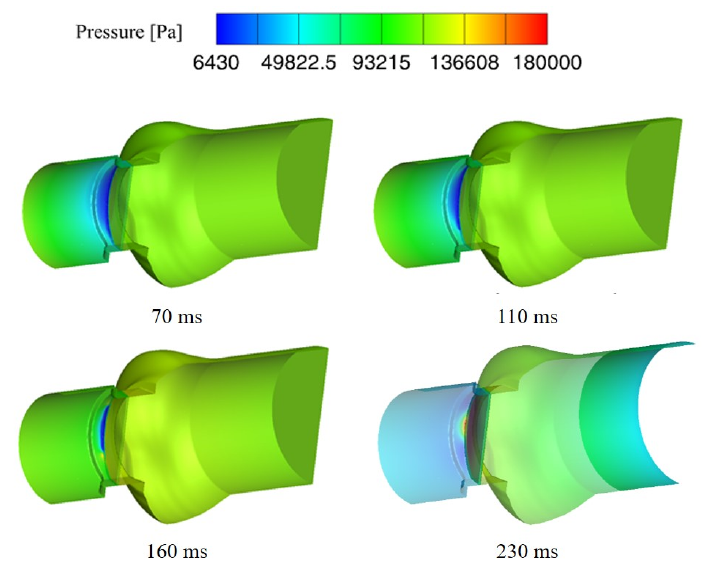
Figure 7. Distribution of downstream pressure after leaflet closing.